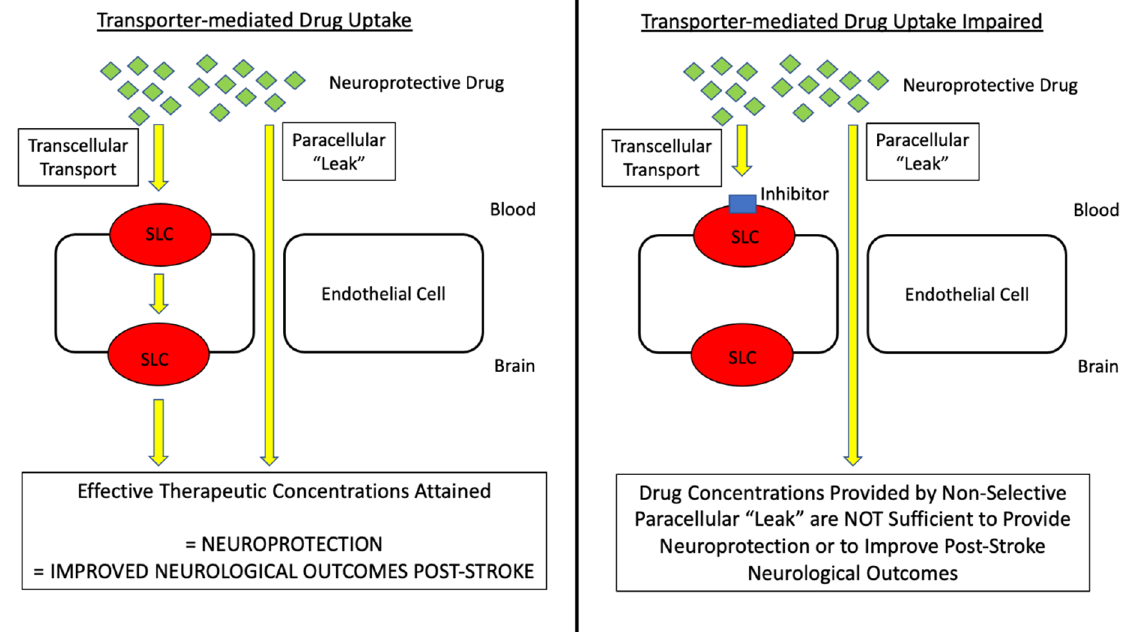
Figure 5. Interplay between SLC Transporter ‐ Mediated Drug Uptake and Passive Paracellular Dif ‐